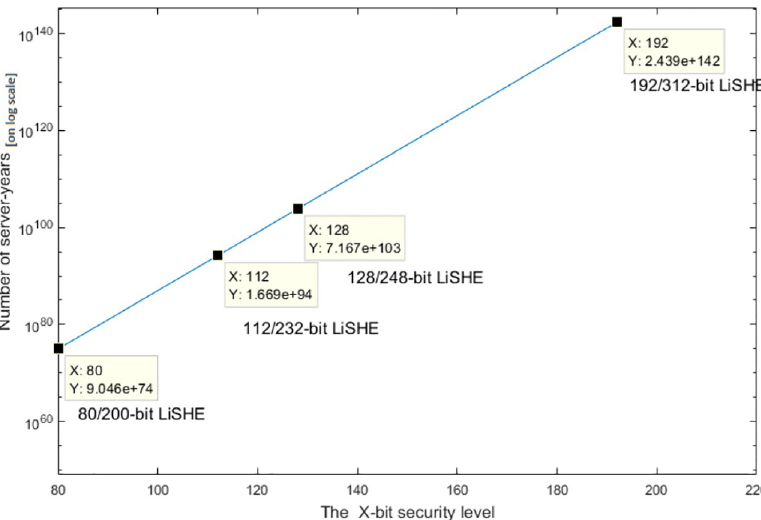
Fig 10. Level of efforts on brute-force attack on a LiSHE key vs. the key length and the key space.